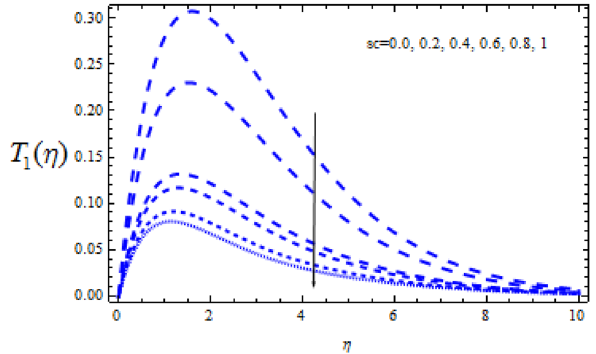
Figure 17. Consequence of Sc on T 1 (η) . .